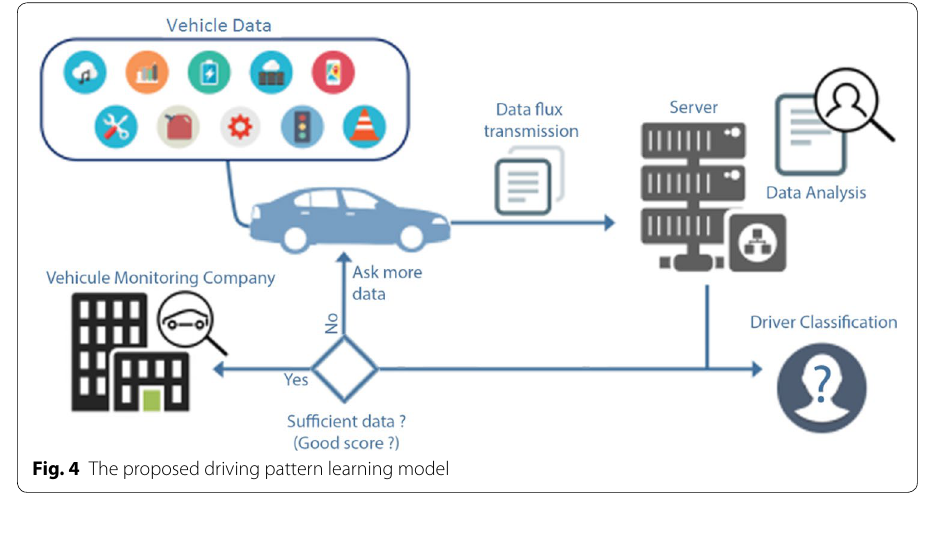
Fig. 4 The proposed driving pattern learning model